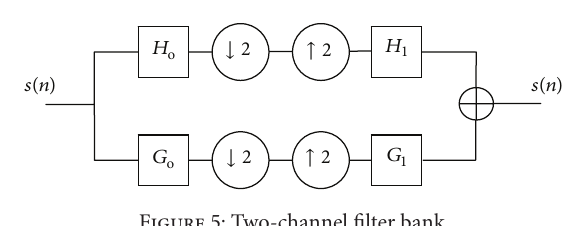
Figure 5: Two-channel filter